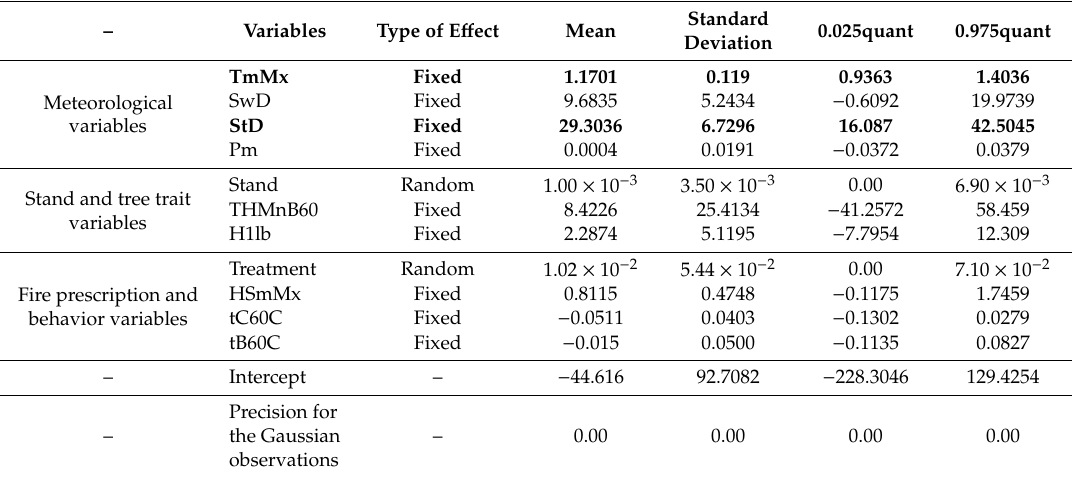
Figure 3. Estimation of fixed effects. TmMx, mean maximum temperature; SwD, days with snow; StD, days with storm; Pm, monthly precipitation; THMnB60, minimum bark thickness at 60 cm from the base; H1lb, height at which first live branch appears; HSmMx, mean maximum scorch height; tC60C, time where temperature is higher than 60 °C in cambium; tB60C, time where temperature is higher than 60 °C in bark. (*) Indicates significant effects. Table 6. Fixed and random e ff ects, mean, standard deviation, and 95% credibility interval in the Bayesian